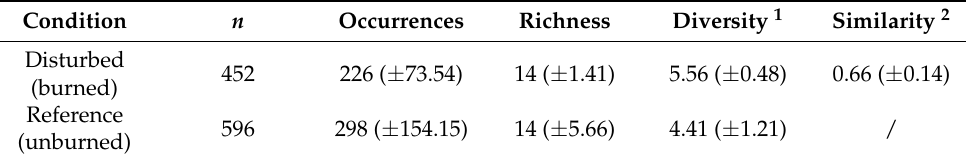
Table 1. Summary of total wildlife observations ( n ) over the entire study period. Between site averages, and standard deviations in parentheses, are given for occurrences, richness, and diversity for the disturbed and reference conditions. Average similarity between the disturbed and reference conditions are also reported.